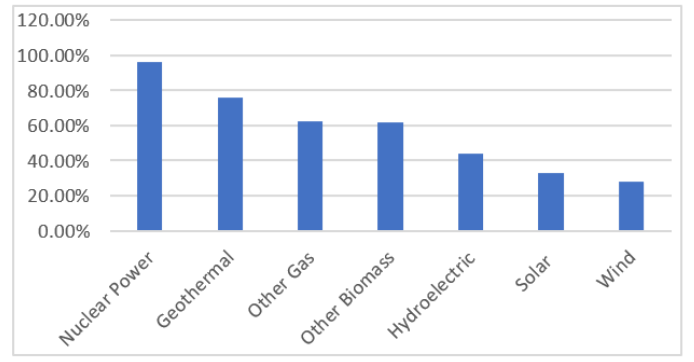
ffi ciencies of di ff erent power sources in 2020 Figure 2. Capacity factors efficiencies of different power sources in 2020 [12]. Figure 2. Capacity factors e